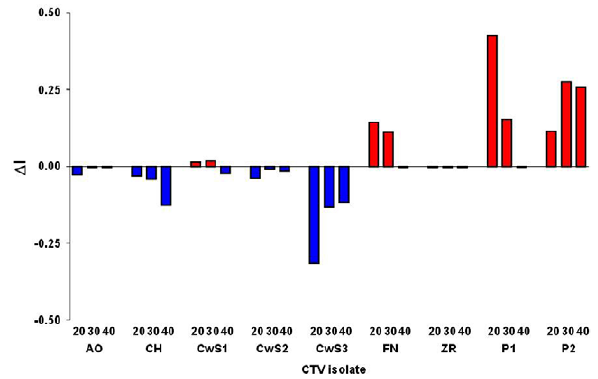
Figure 2. ΔI values of genomic variant richness in relation to increasing number of sampled clones averaged over 24 possible sampling orders of four sets based on the results of the SSCP analy- sis of nine Citrus tristeza virus isolates.